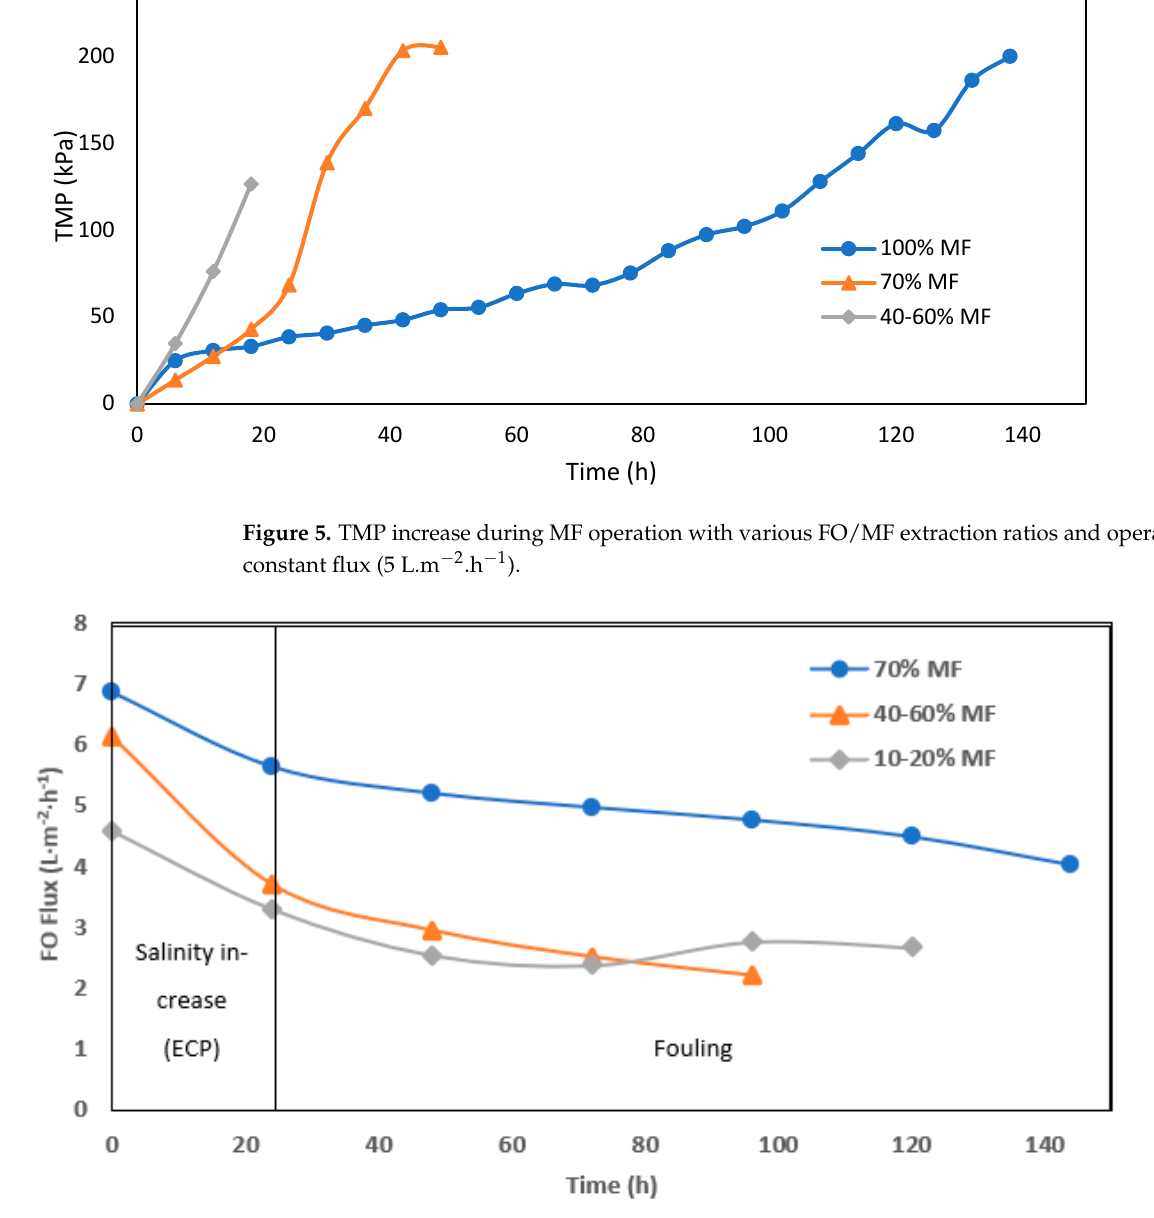
Figure 5. TMP increase during MF operation with various FO/MF extraction ratios and operation at constant fl ux (5 L.m − 2 .h − 1 ).